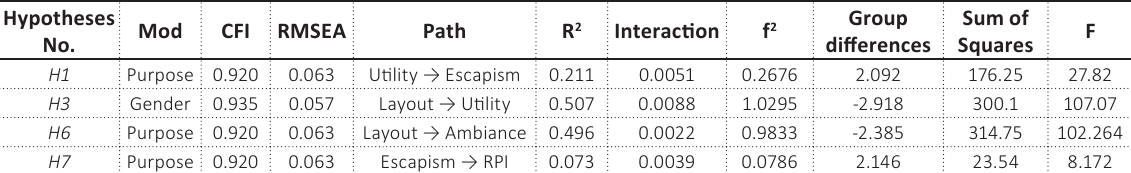
Table 7. Interaction effects